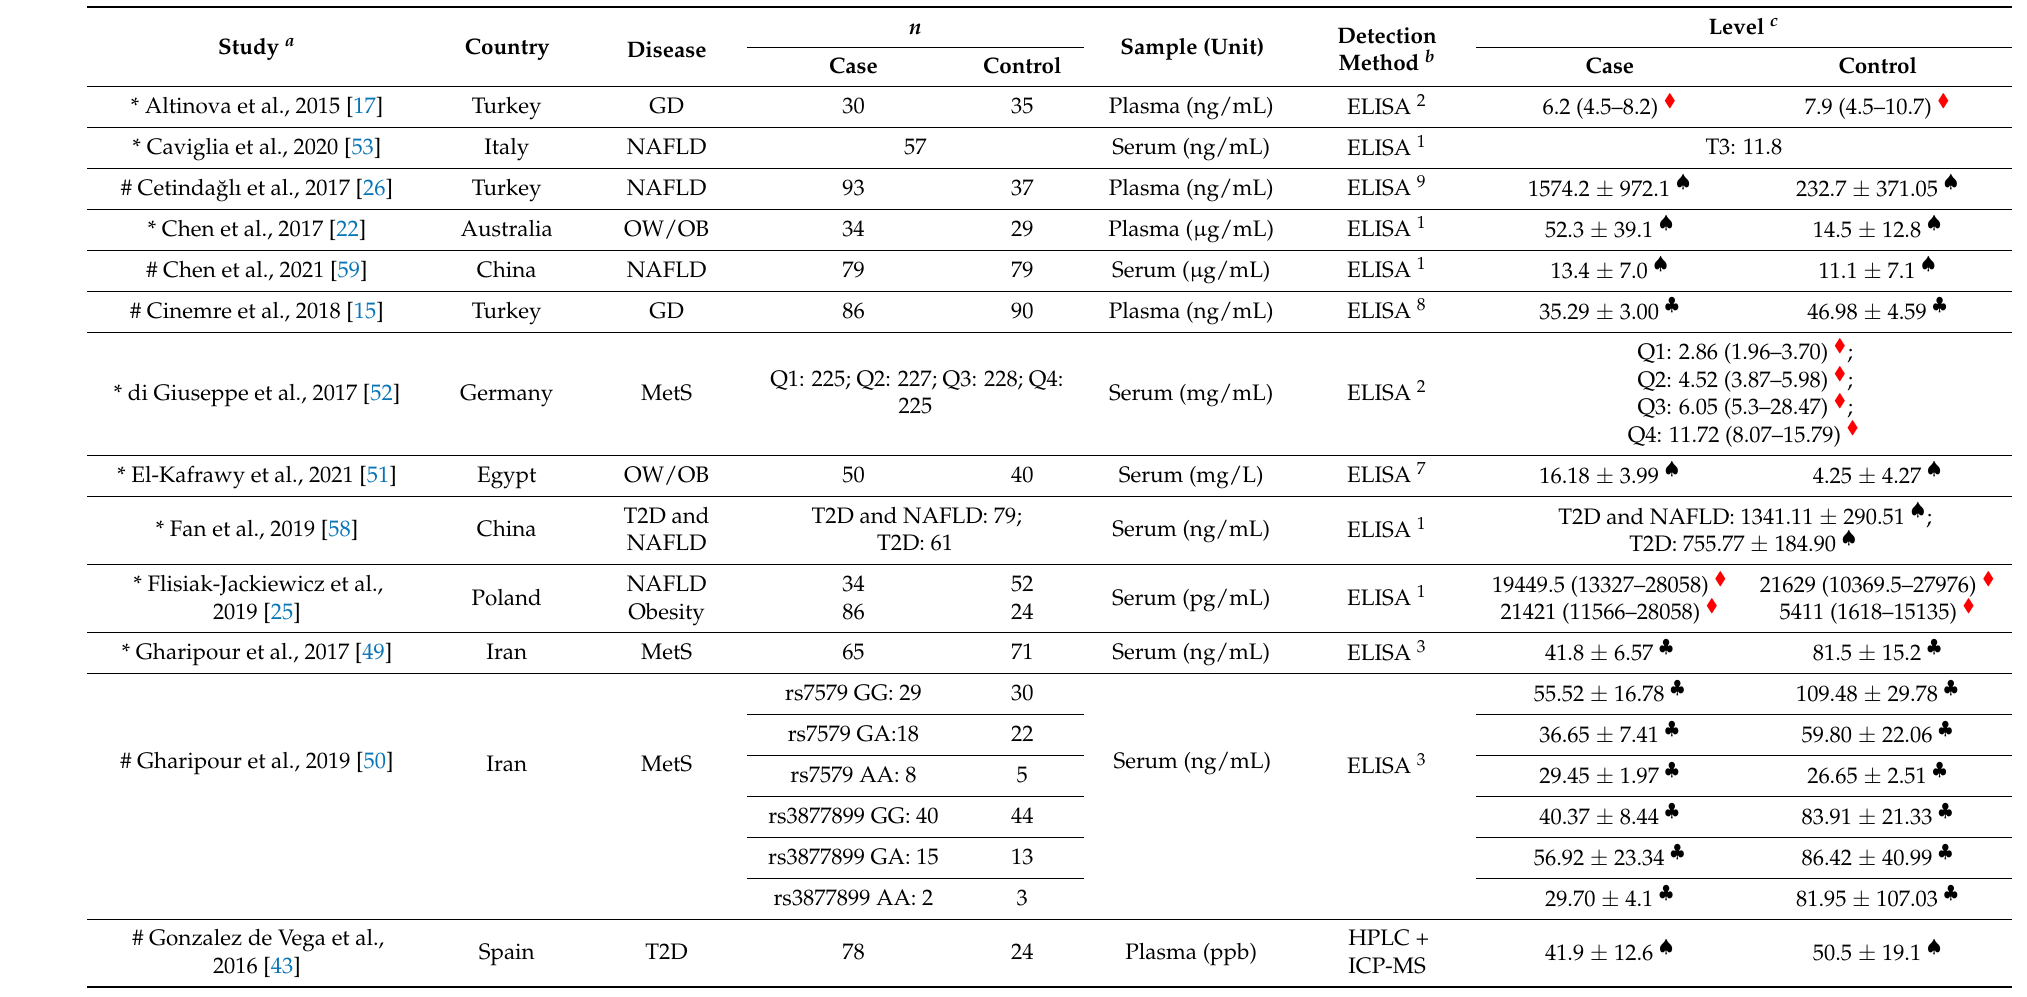
Table 1. Characteristics of the selected studies for